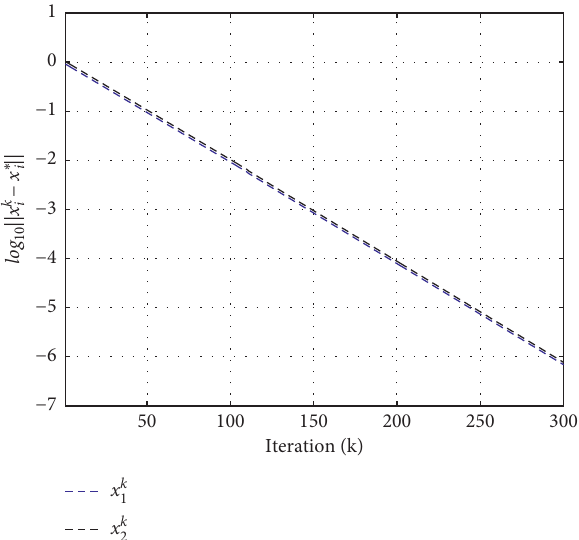
Figure 6: Convergence of the primal variables x x ∈ R 10 illustrated with scalar valued complicating variable y , 2 when the primal problem (39) is solved using the gradient method followed by primal decomposition. The figure shows x k converge to their optimal solutions x ∗